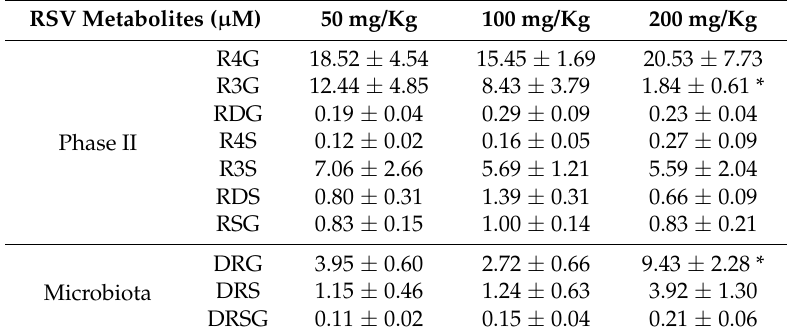
Table 1. The results obtained for each metabolite ( µ M) present in serum respect each group of rats treated with